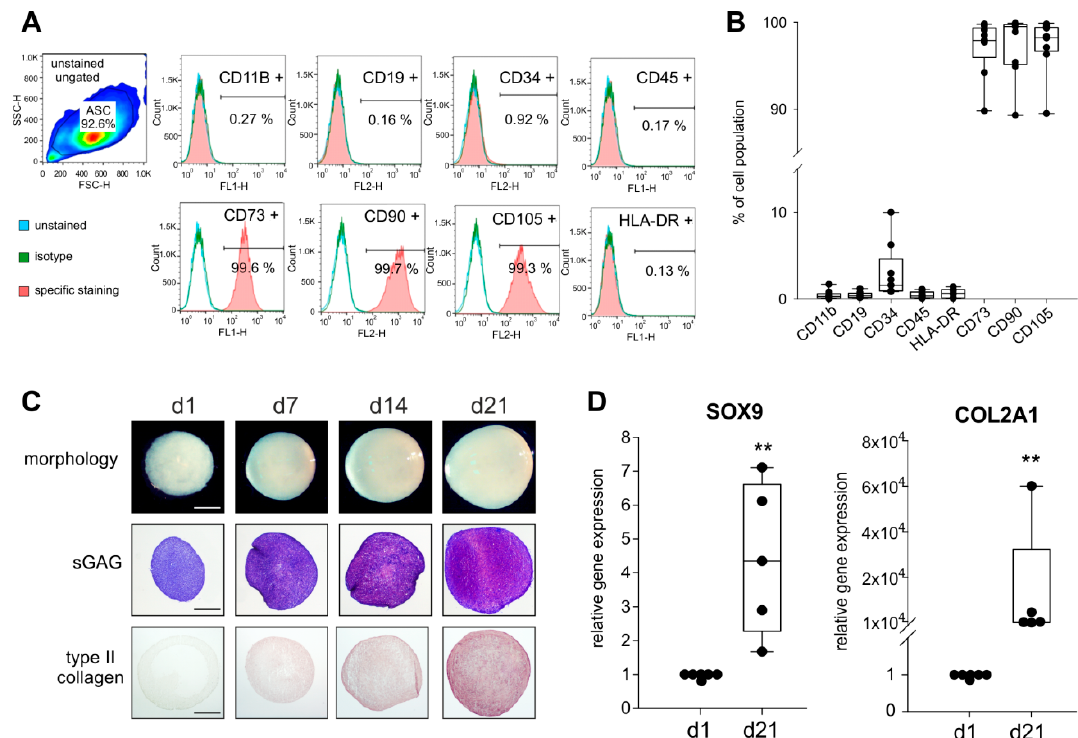
Figure 1. Analysis of mesenchymal stem cells (MSC)-specific surface markers and chondrogenic differentiation capacity of synovial adipose tissue-derived MSCs (sASC) obtained from osteoarthritis (OA) patients. ( A ) Human sASCs derived from OA patients were positive for CD73, CD90, and CD105 and were negative for CD11b, CD19, CD34, CD45 and human leukocyte antigen–DR isotype (HLA-DR) using FACS analysis (blue line—unstained negative control, green line—isotype control, red line—the target surface marker). ( B ) Quantification of MSC-specific marker expression on sASCs from eight different OA patients ( n = 8). Data are presented as box plots with the 10th, 25th, 50th (median), 75th, and 90th percentiles. Each black circle represents an individual patient: ( C ) Macroscopic, histologic (sGAG) and immunohistochemical (type II collagen) analysis of untreated chondrogenic sASC pellets at day1, day 7, day 14, and day 21 of differentiation (bars, 500 μ m). ( D ) Relative gene expression of SOX9 and type II collagen in untreated ASC pellets after 21 days of chondrogenesis. Data are presented as box plots with the 10th, 25th, 50th (median), 75th, and 90th percentiles. Each black circle represents an individual patient ( n = 5–6). Significant p -values against untreated control are presented as ** = p < 0.01.